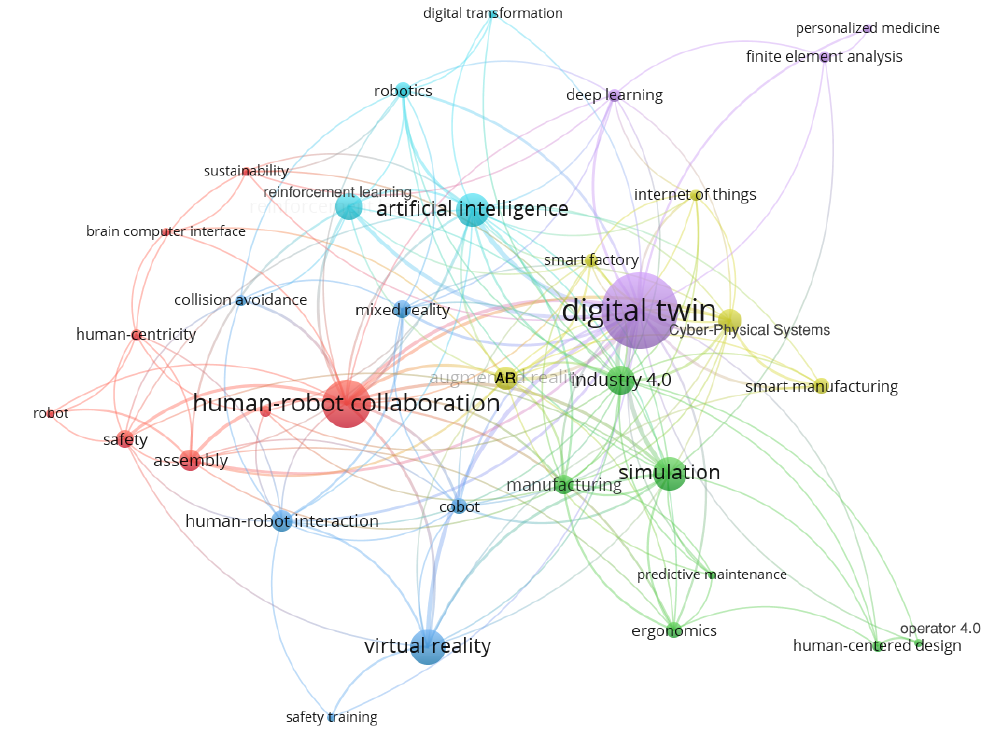
Figure 4. Keyword Co-occurrence Network